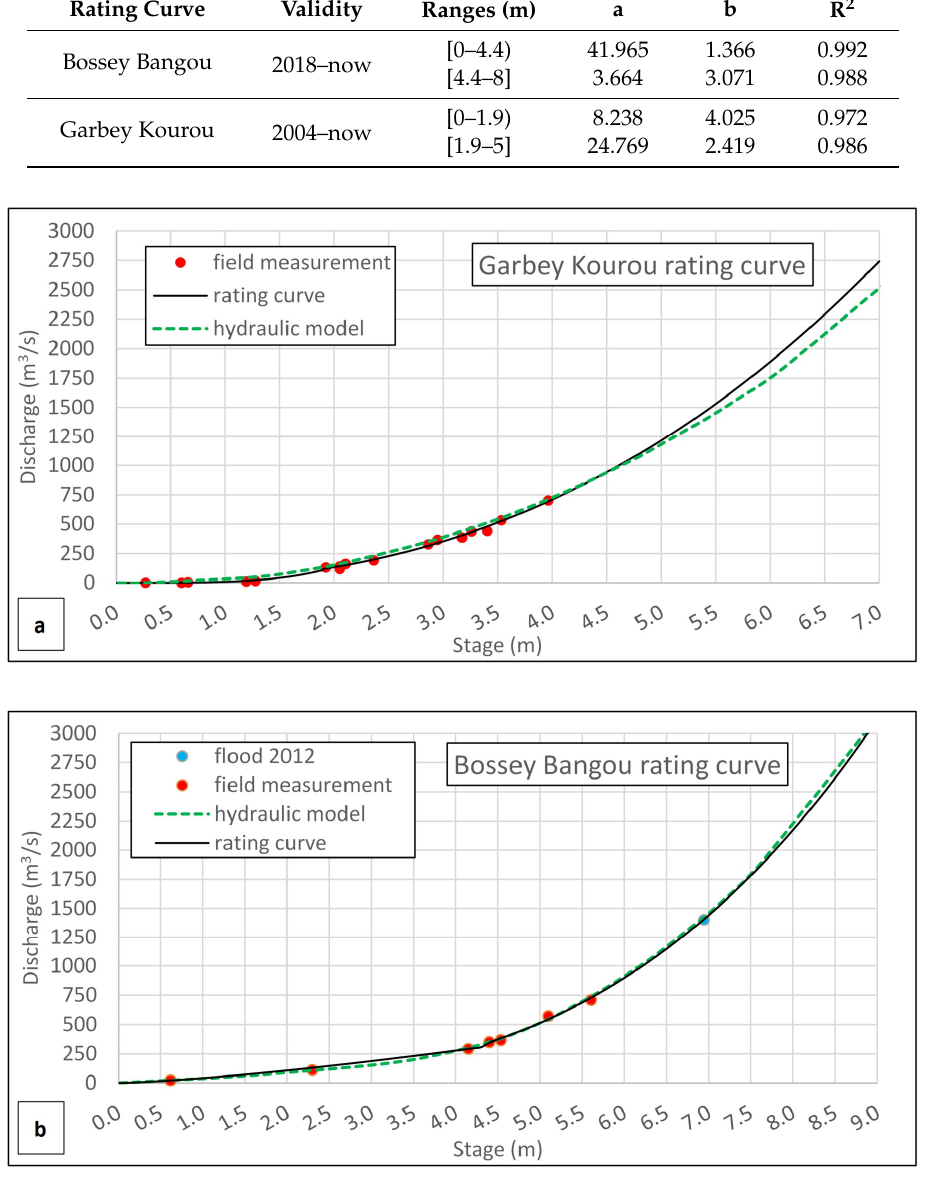
Figure 13. The two gauging stations of the Sirba River: ( a ) Garbey Kourou; ( b ) Bossey Bangou. Comparison between the rating curve (continuous black line), field measurements of stage/discharge (red points), the level of 2012 flood (blue point) and the rating curves computed with the hydraulic model (dotted green line).